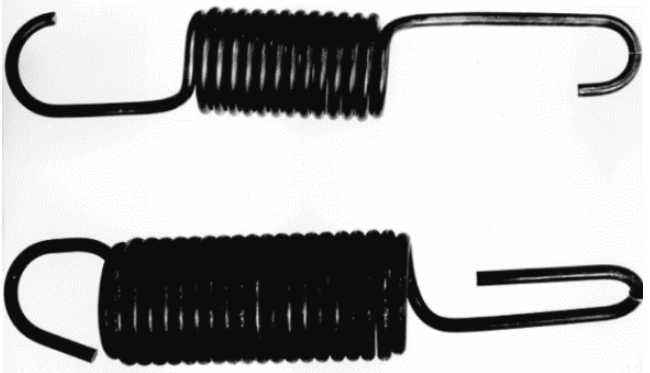
Figure 8. The Ti spring ( top ) carries the same load as the steel spring ( bottom ) but weighs 1.45 kg compared to 4.35 kg for the steel spring due to the lower density and the fewer coils required [30].